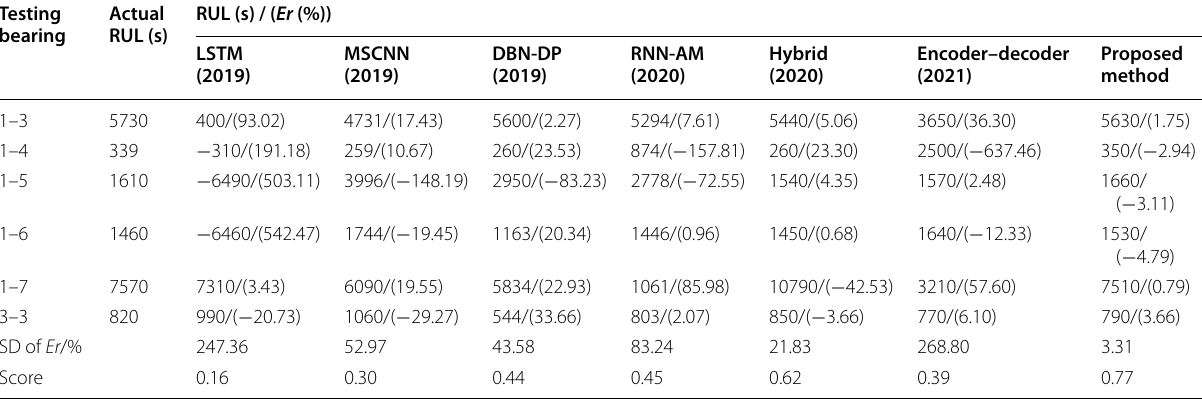
Table 5 RUL prediction performance Testing